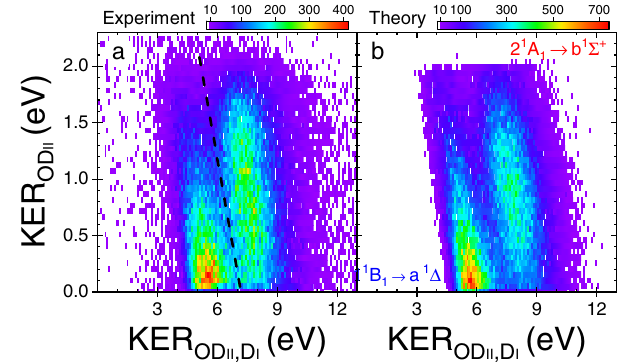
Fig. 5 | The KER correlation maps of sequential fragmentation of water dica- tions. The measured yield of D 2 O 2+ breakup into D + +D + +O( 3 P) as a function of and KER OD : a Experiment and b Theory. The two panels nicely match KER OD II ,D I II each other, aided by the choice of similar statistics in the theory to match the experimentaldataquality.Theblack-dashedlineinpanel( a )isusedtoseparatethe two sequentialfragmentationpaths (seetext),speci fi cally 2 1 A 1 → b 1 Σ + (right) from 1 1 B 1 → a 1 Δ (left). This visualization of our pathway separation method, though correct, is simpli fi ed in practice by plotting the same data as a function of ∘ rotation of the spectrum in − KER +KER OD and KER OD KER OD OD II , i.e., a 45 II ,D I II II ,D I +KER OD axis and associate panel ( a ). Then, we project it onto the KER=KER OD II ,D I II events larger (smaller) than KER=7.18eV with the b 1 Σ + (or a 1 Δ ) channel (further details and the KER distributions are provided in Supplementary Note 1). Source data are provided as a Source Data fi